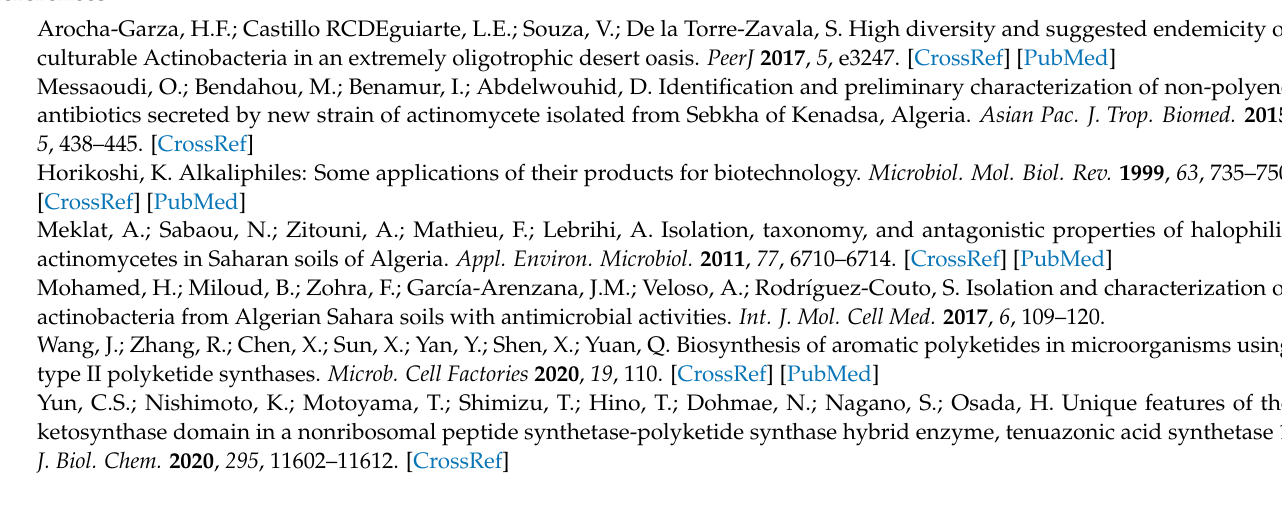
Table S2: NMR data of 6,7-dimethoxy-3-phenylchromen-4-one (54) in CD 3 OD- d 4 ( 1 H 700 MHz, 13 C 176 MHz). Table S3: NMR data of 5 (cid:48) -hydroxy-2 (cid:48) ,3 (cid:48) ,4,4”-tetramethoxy-p-terphenyl (65) in CD 3 OD- d 4 ( 1 H 700 MHz, 13 C 176